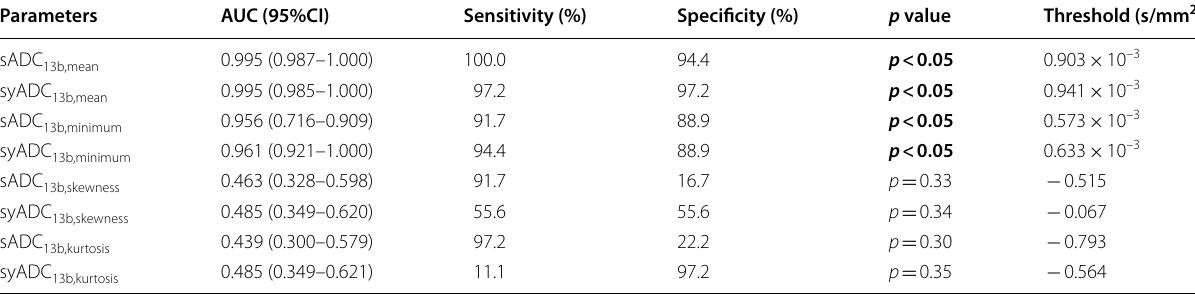
Table 3 Diagnosis performance on cervical cancer of histogram-derived scanned and synthetic 13b-protocol ADC values with a b value of 0 and 1200 s/mm